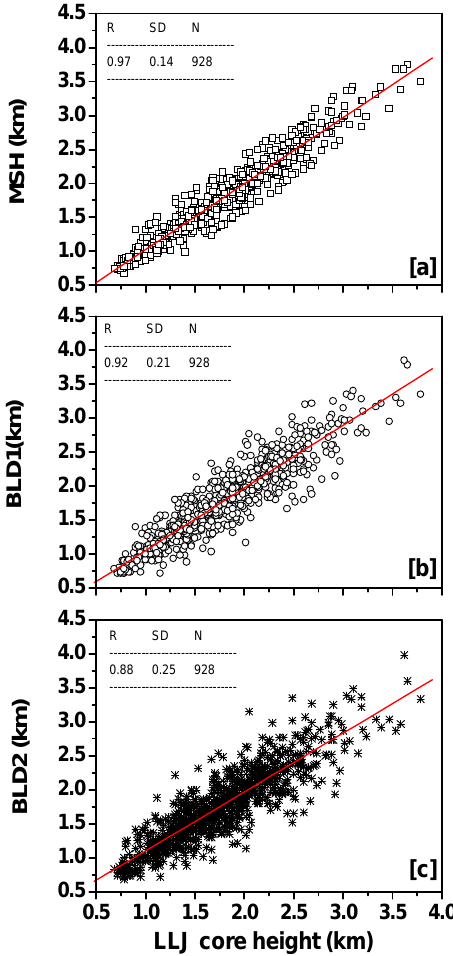
Fig. 7. Scatter plots between LLJ core height and boundary layer top determined using (a) Maximum Shear Height method (denoted as MSH), (b) ε method (denoted as BLT1), and (c) C 2 n method (de- noted as BLT2). Statistical information can be read as R: correlation coefficient; N: number of data points; SD: standard deviation of the